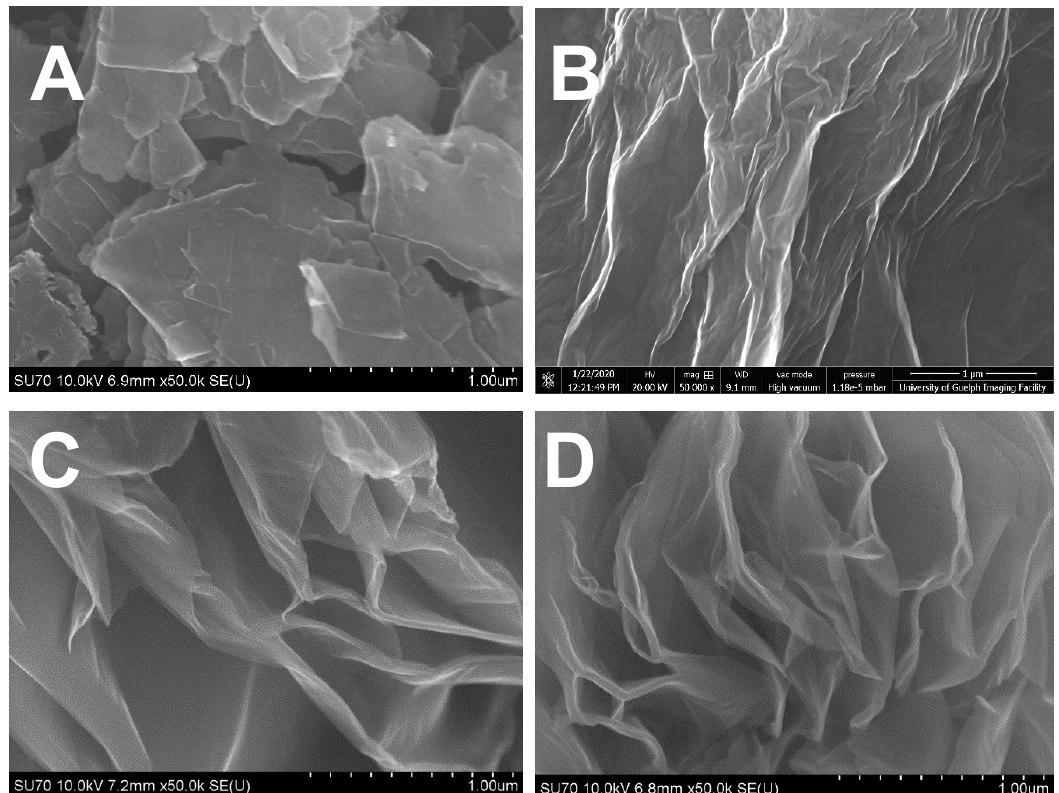
Figure 1. SEM images of ( A ) graphite, ( B ) graphene oxide, ( C ) interconnected reduced graphene oxide (IC-rGO), and ( D ) N-doped IC-rGO (N-IC-rGO). Figure 1C,D (reproduced from ref. [81], with permission from Elsevier, 2020).